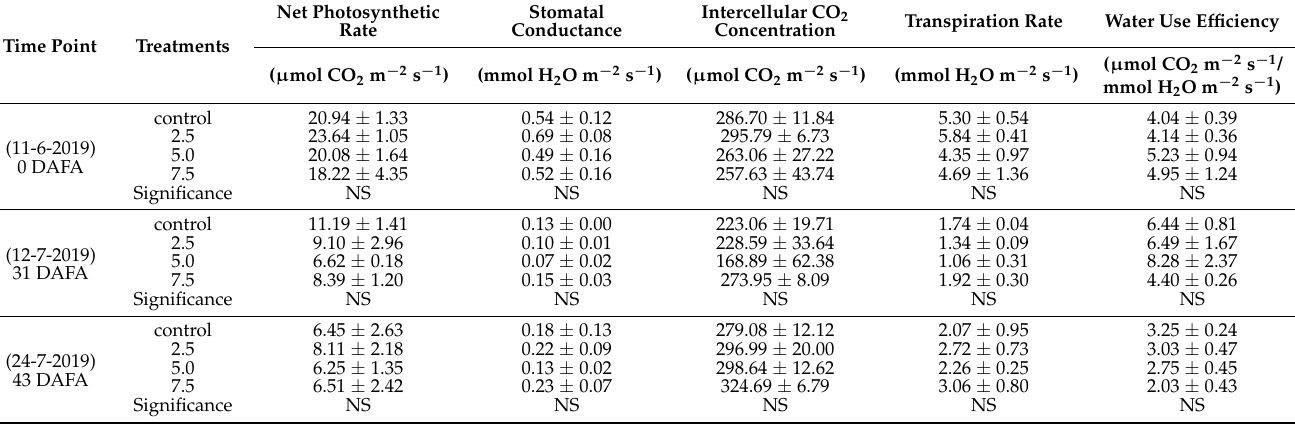
Table 3. Net photosynthetic rate, stomatal conductance, intercellular CO 2 concentration, transpiration rate and water use efficiency in leaves (3rd or 4th fully developed leaf from the top) of tomato plants at 0, 31, and 43 DAFA of sodium hypochlorite at three different concentrations of chlorine in the supplied nutrient solution.